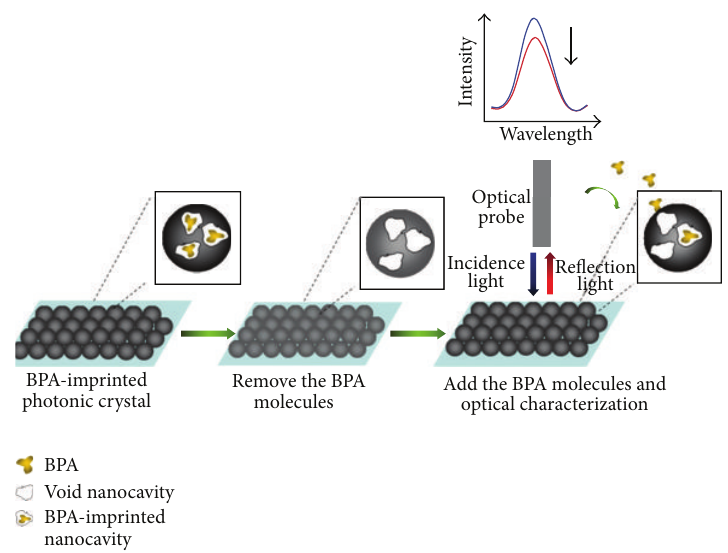
Figure 15: Experimental procedure for the detection of BPA using a photonic crystal sensor